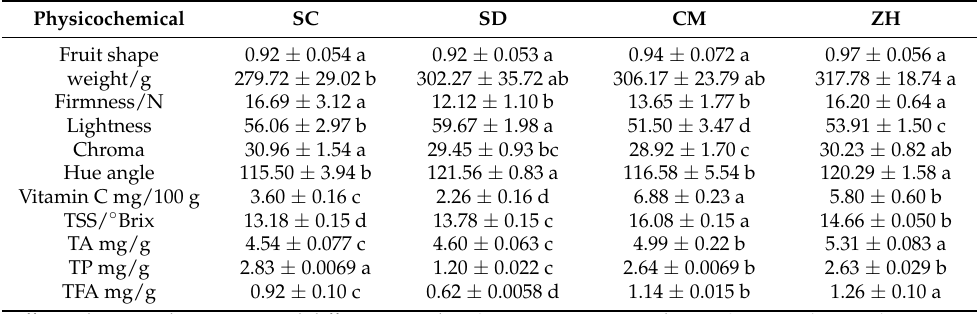
Table 1. The physicochemical parameters of Cuiguan pear with different